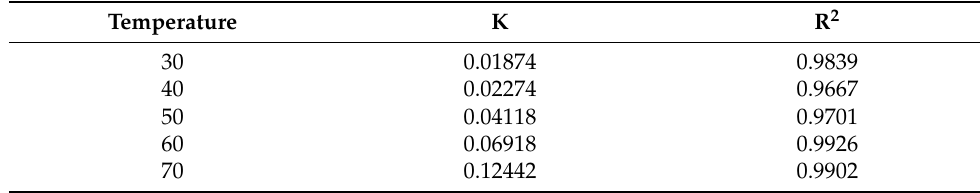
Table 3. Apparent rate constants K correlation